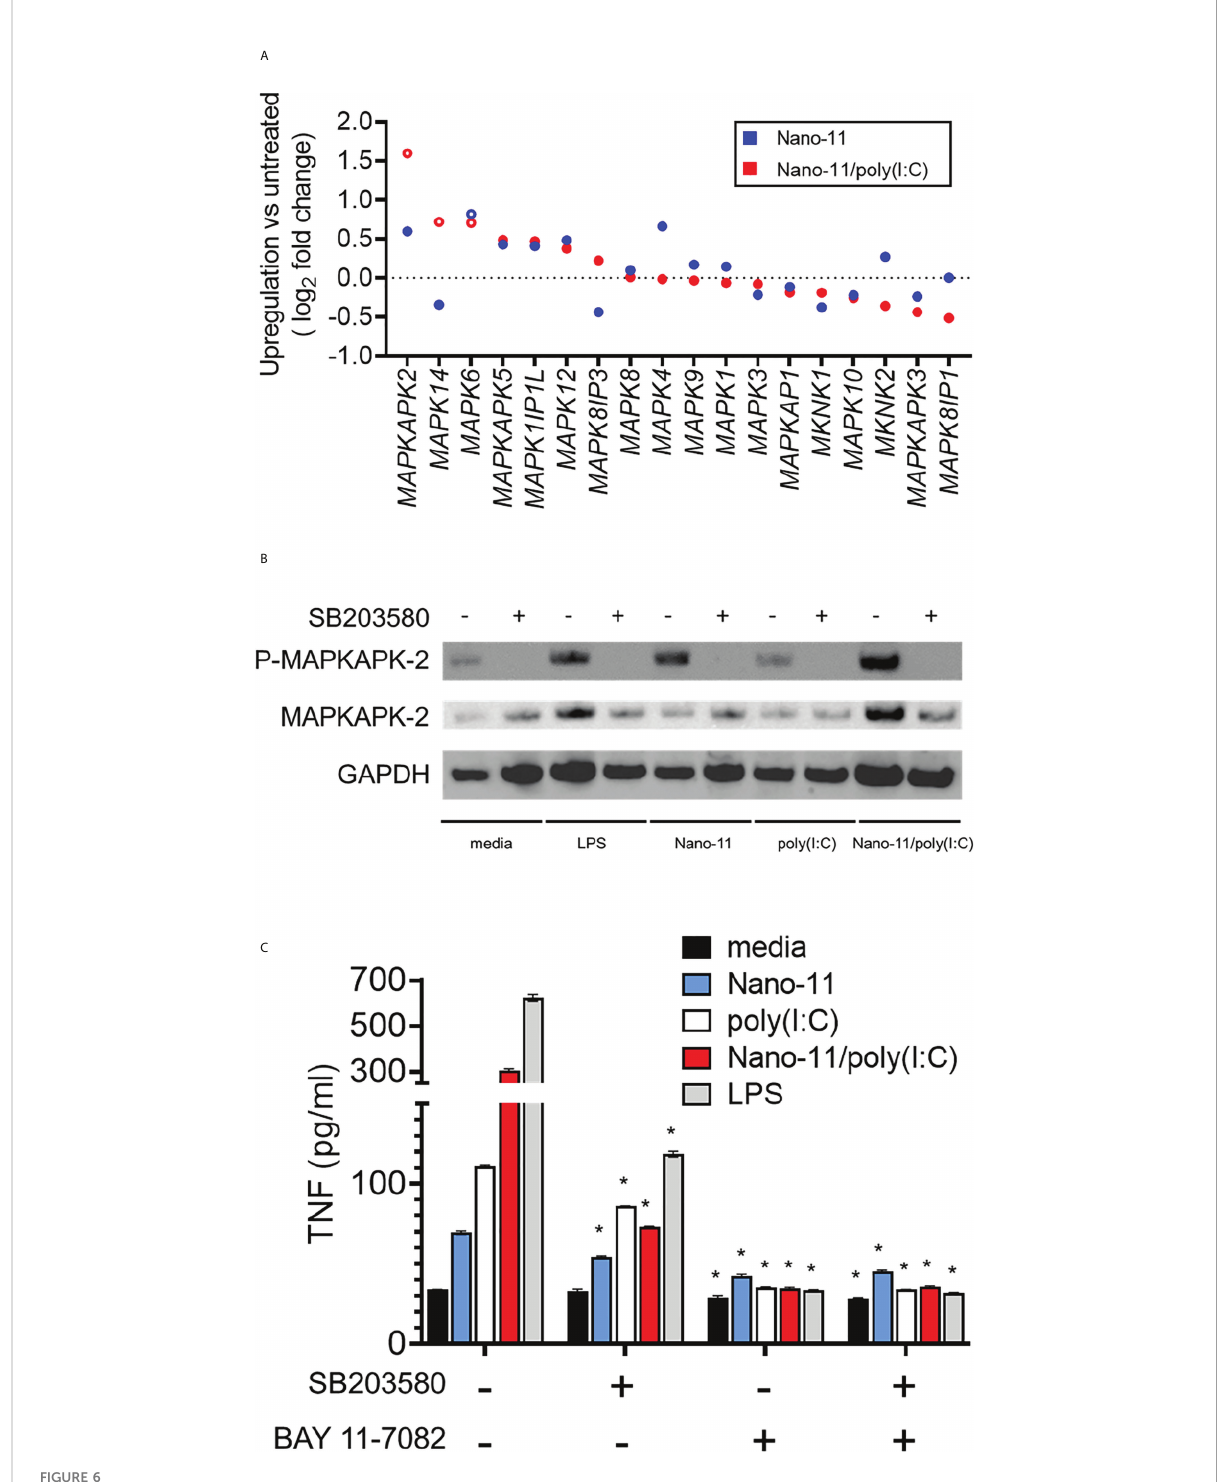
FIGURE 6 Mitogen-activated protein kinase network induced by Nano-11 ± poly(I:C). (A) Fold change of expression of MAP kinase family genes. No change in mRNA expression is shown by the dashed line and each dot represents the mean of three different animals. (B) The p38 MAPK inhibitor (SB203580) inhibits the phosphorylation of MAPKAPK2 by Nano-11 and Nano-11/poly(I:C). (C) Inhibition of p38 MAPK (SB203580) and NF- k B (BAY 11-7082) inhibits the secretion of TNF induced by Nano-11, poly(I:C) and Nano-11/poly(I:C). The bars indicate the mean ± SE of three replicates and statistical analysis was conducted using one-way ANOVA with Tukey test for multiple comparisons. * indicates a statistically signi fi cant effect of the inhibitor(s) on TNF secretion (p < 0.05). Results are representative of two independent